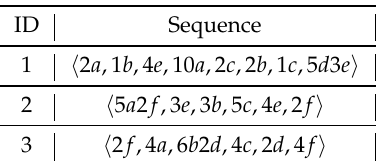
Figure 6. Example input